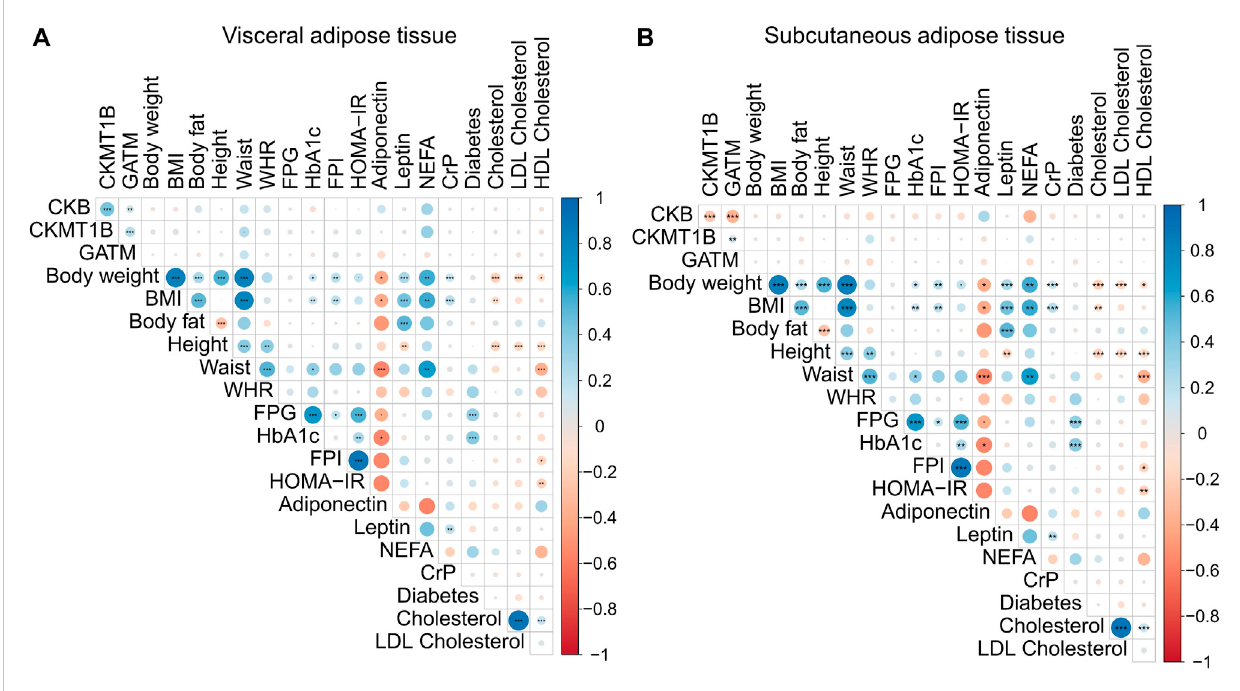
Correlations of CKB , CKMT1B , and GATM with clinical parameters. The presented data are based on RNA-sequencing data of omental visceral (A) and abdominal subcutaneous (B) adipose tissues from 1,479 individuals of the LOBB. The correlations were calculated with Pearson ’ s correlation coef fi cient. p -values were adjusted for multiple comparisons using Hommel ’ s method (Hommel, 1988). Positive correlations are shown in blue, while negative correlations are represented in red. The size of the dot refers to the degree of correlation. Signi fi cance; p adj. < 0.001 (***), p adj. < 0.01 (**), andp adj. < 0.05(*).BMI:bodymassindex.CrP:c-reactiveprotein.FPI:fastingplasmainsulin.FPG:fastingplasmaglucose.HbA1C:hemoglobin A1C.HDL: high-densitylipoprotein. HOMA-IR: homeostaticmodel assessment for insulin resistance. LDL: low-density lipoprotein.NEFA:non-esteri fi edfatty